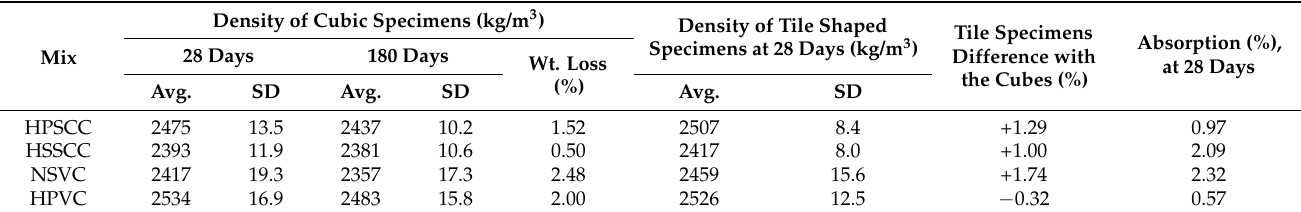
Table 5. Density of 100 mm cubes and tile shaped specimens, and absorption test results. Abbreviations: High-performance self-consolidating concrete (HPSCC), high-strength self-compacted concrete (HSSCC), normal strength-vibrated concrete (NSVC), and high-performance highly-viscous concrete (HPVC).